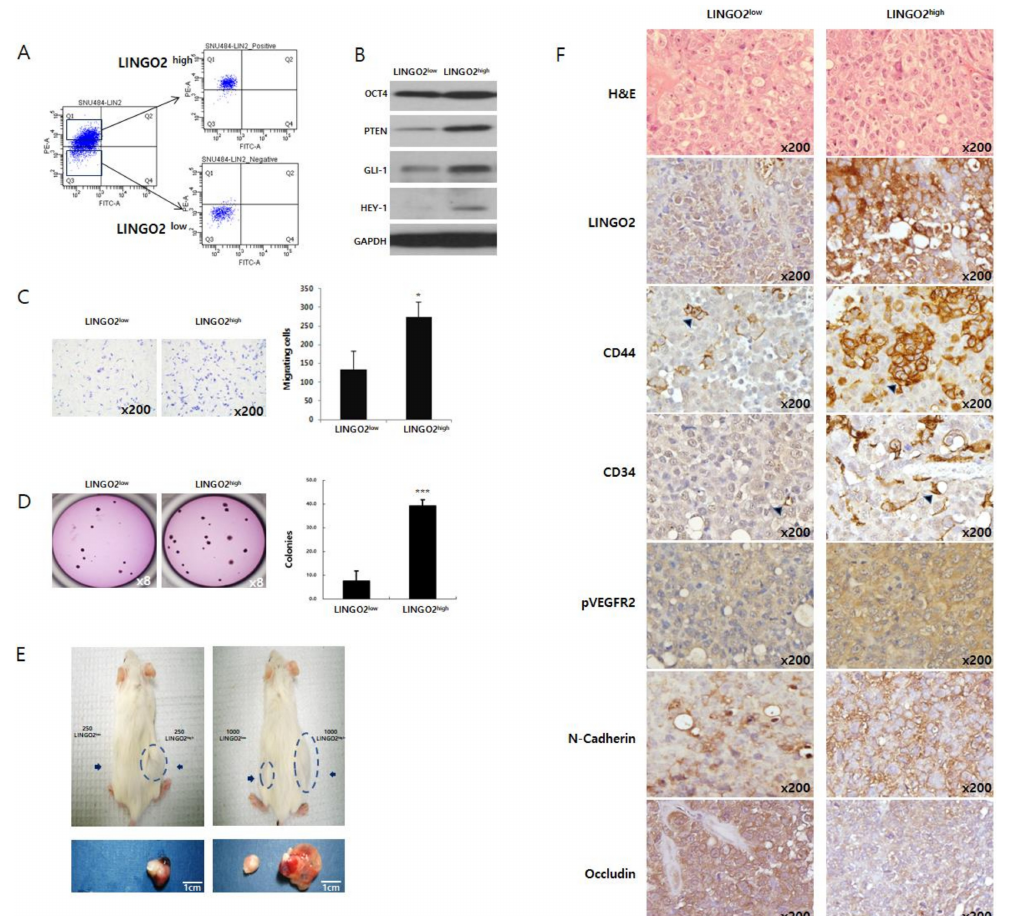
Figure 2. Cells highly expressing LINGO2 possess cancer stem cell characteristics. ( A ) Based on surface LINGO2 expression, SNU484 cells were sorted into LINGO2 high and LINGO2 low cells. ( B ) Elevated expression of cancer stem cells associated genes including OCT4, PTEN, Gli-1, and Hey-1 was observed in LINGO2 high cells than in LINGO2 low cells. ( C ) Cell migration increased by approximately 2-fold and ( D ) clonogenic ability increased by approximately 4-fold in LINGO2 high cells than in LINGO2 low cells (* p < 0.1, *** p < 0.001). Tumours are indicated by the dotted lines and arrows. ( E ) To assess the minimal number cells required for tumorigenesis, cells were subcutaneously injected into NOD/SCID mouse ( n = 3 per group). LINGO2 high cells formed tumor mass with 250 cells whereas LINGO2 low started to form tumor with 1000 cells and more. Arrows indicated. ( F ) Immunohistochemical analysis of mouse tumor tissues revealed up-regulated LINGO2, CD44, CD34, pVEGFR2, and N-Cadherin and down-regulated Occludin in LINGO2 high tumor tissues. (Arrows